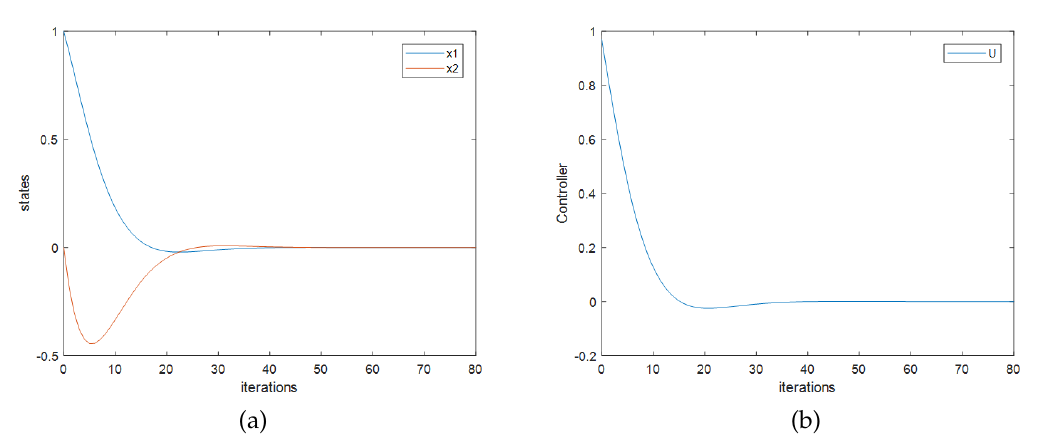
Figure 3. Closed-loop response and the control effort of system 2 with K = [ 0.91710.4143 ] . ( a ) Trajectories of state values. ( b ) Trajectory of control